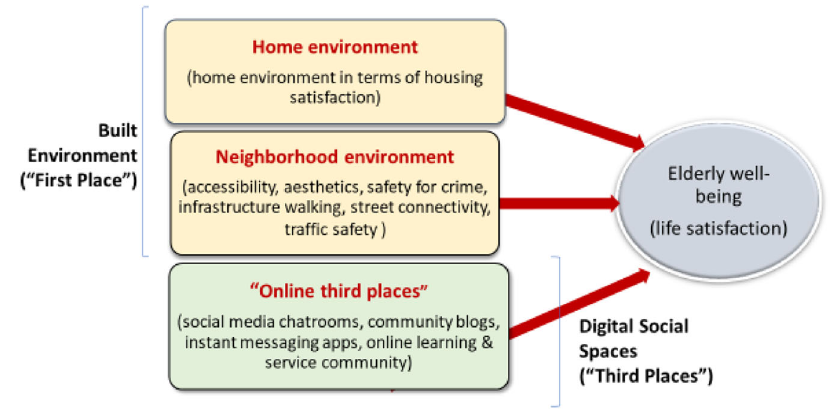
Fig. 1 Conceptual framework of elderly well-being and